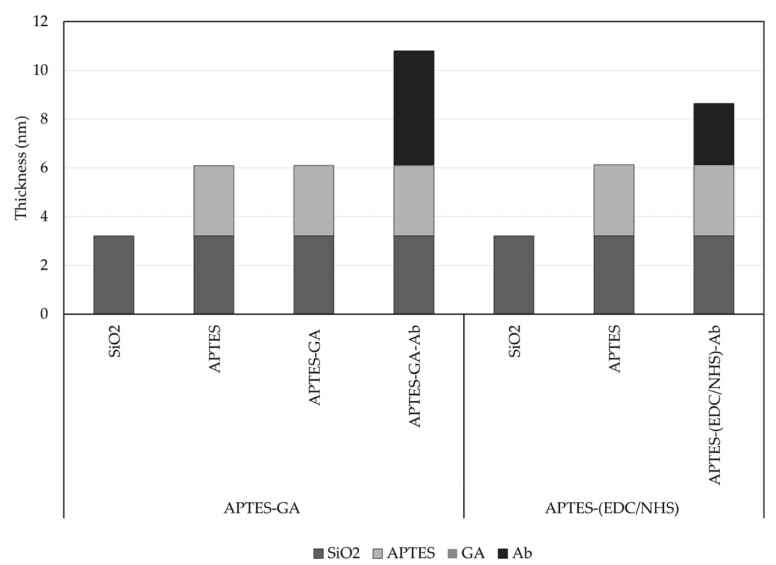
Figure 8. Thickness of the layers after each stage of anti-TNF-alpha coating using APTES-GA technique and APTES-(EDC/NHS) technique.